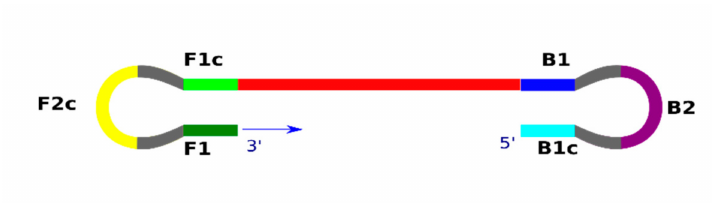
Figure 2. Schematic of a single-stranded DNA dumbbell-like structure, an artificial template for further amplification of the reaction using the LAMP technique. (Based on http://loopamp.eiken.co. jp/e/lamp/principle.html (accessed on 1 June